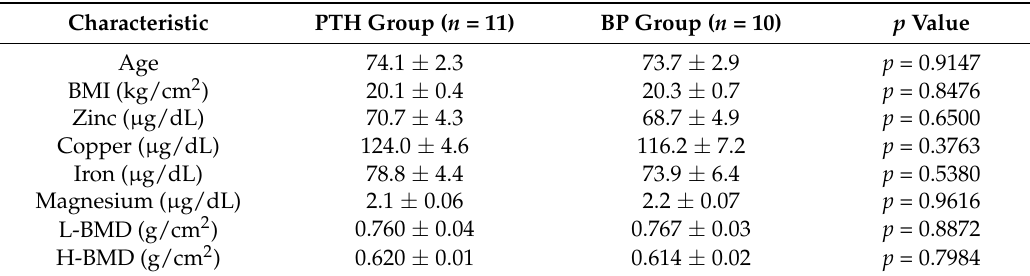
Figure 1. Percent changes in ( a ) Serum Zinc, ( b ) Serum Copper, ( c ) Serum Iron, and ( d ) Serum Magnesium were examined at one week and 1, 2, 4, 6, 8, 10, and 12 months after denosumab treatment. Results are expressed as the mean ± SE. Table 2. Baseline values prior to